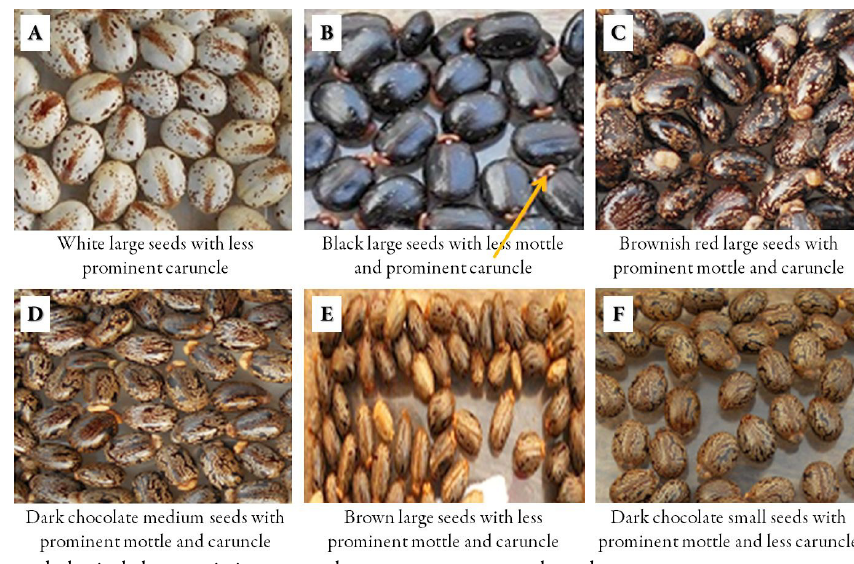
Fig. 1. Different seed physical characteristics among the castor genotypes evaluated Note: A - Seeds of Acc. 045, B - Acc. 001, C - Acc. 048, D - Acc. 036 M, E - Acc. 012 and F - Acc. 036